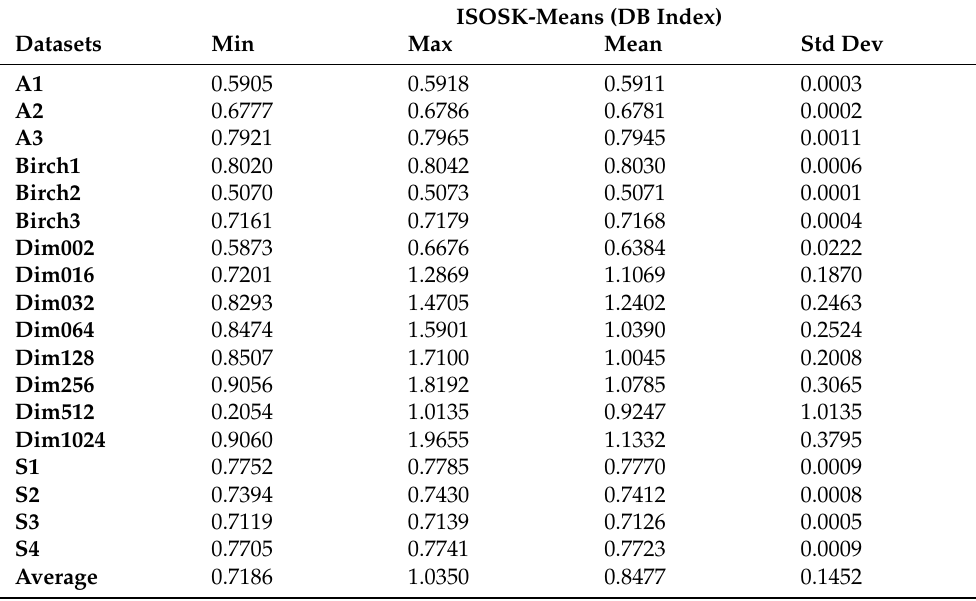
Table 6. Computational results of ISOSK-means on 18 synthetic datasets.